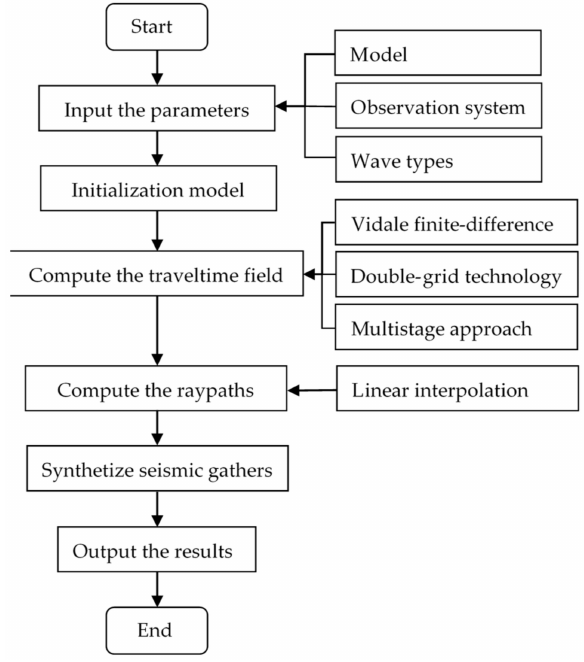
Figure 10. The flowchart of the improved